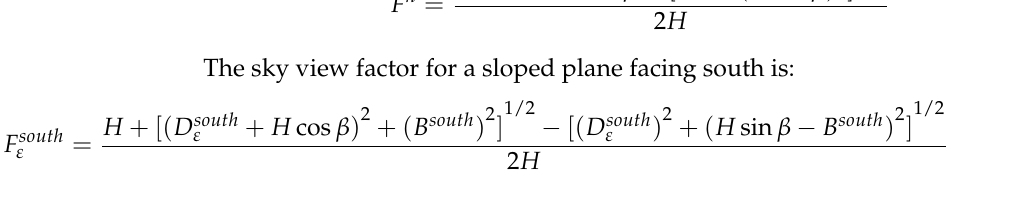
Figure 2. Variation of row distances with sloped-plane angle ε , β = 25 ◦ , H = 2.12 m, φ = 32 ◦ = .